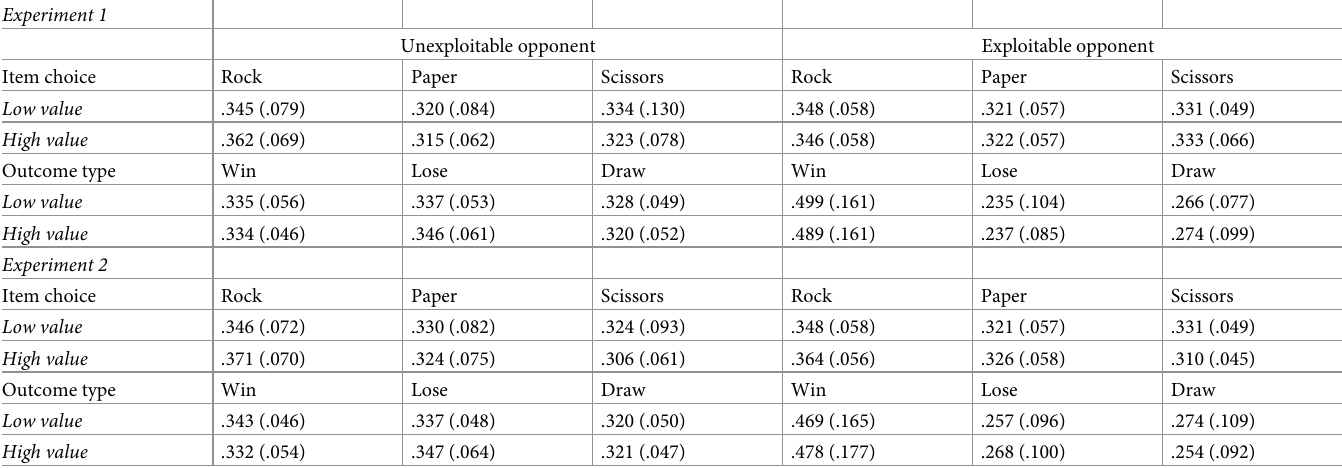
Table 2. Item and outcome proportions as a function of opponent and value in Experiments 1 and